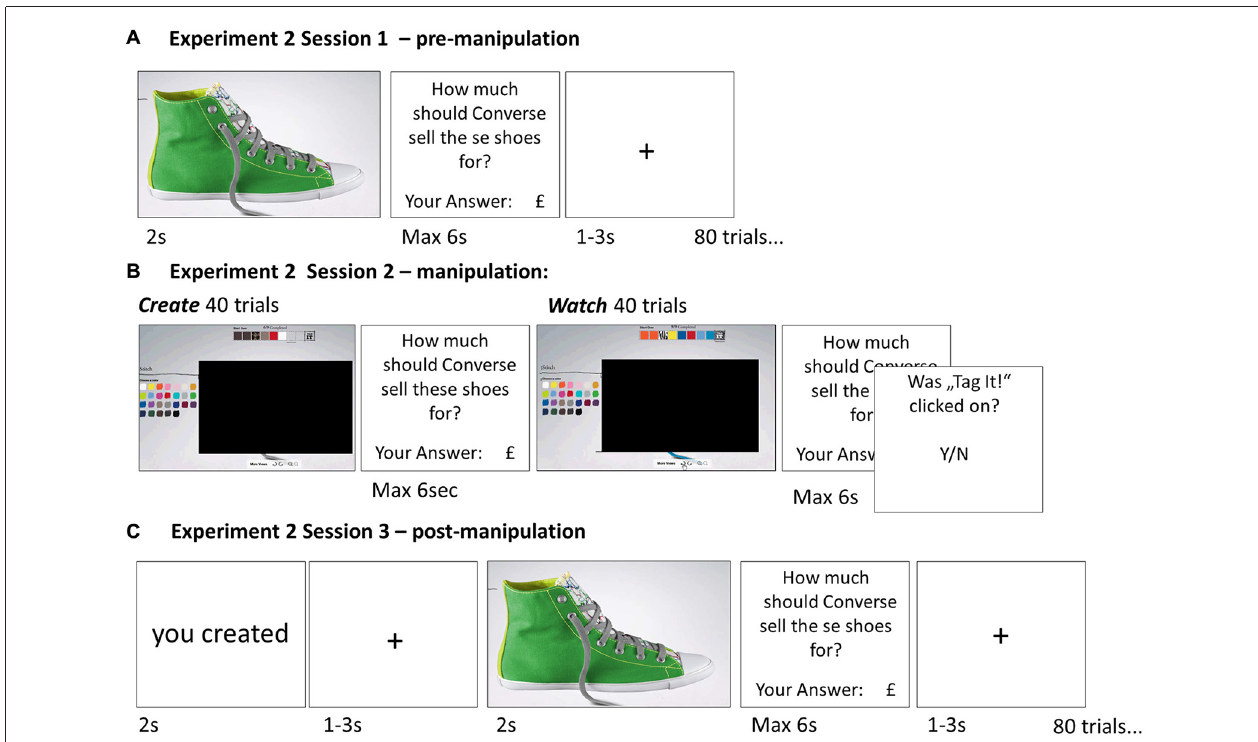
FIGURE 2 | Paradigm Experiment 2—Belief manipulation. In order to manipulate subjects’ beliefs, rather than elicit them, we conducted a modified version of the task. Session 1 (A) of Experiment 2 was identical to Experiment 1. However, in Session 2 (B) the display of the actual shoe was occluded such that subject’s knowledge of which shoe was created and which was watched was more ambiguous and thus more easily manipulated. In Session 3 (C) before the shoe was displayed, subjects were instructed whether the shoe was created or watched in Session 2; this information was false half of the